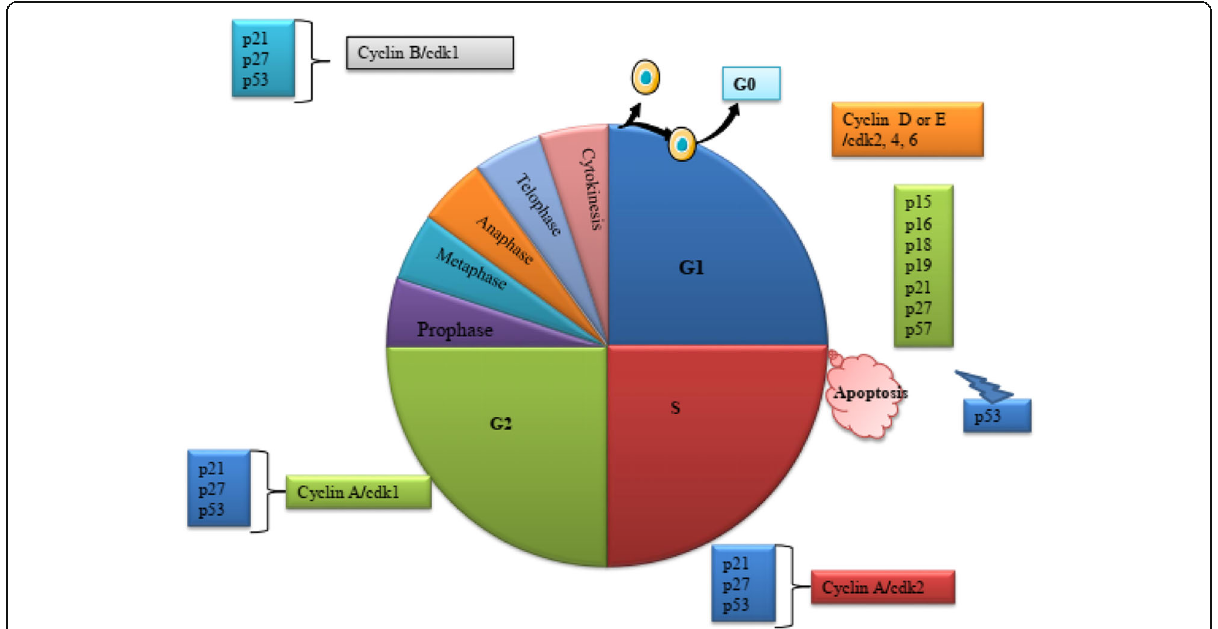
Fig. 1 Dynamics of the cell cycle with its associated cyclin-cyclin dependent kinase complexes. The interphasic cells, at their G 1 phase, are diploids (2 n ). As to prepare the cell for an eventual division, its genetic material, i.e., DNA, is replicated during the S phase. Thus in the later S phase and G 2 phase, the cell has a doubled DNA (4 n ). The mitotic division occurs from Prophase through Telophase, as shown in the figure. At the end of mitosis, there is a formation of two daughter cells. G 0 symbolizes a quiescent state through which cells could eventually go. The cyclin-cyclin-dependent kinases reflected on the figure are checkpoints of the cell cycle, each of which could eventually determine the cell ’ s fate with respect to the presence and/or absence of mitogens and growth